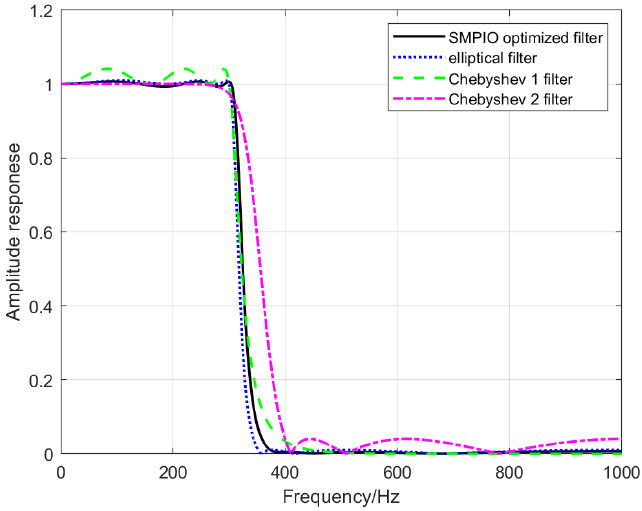
Figure 5. Amplituderesponsecomparisonofvarioustypesoffilters(0Hz~1000Hz, m Figure 5. Amplitude response comparison of various types of filters (0 Hz~1000 Hz, m = 6, amplitude optimized).